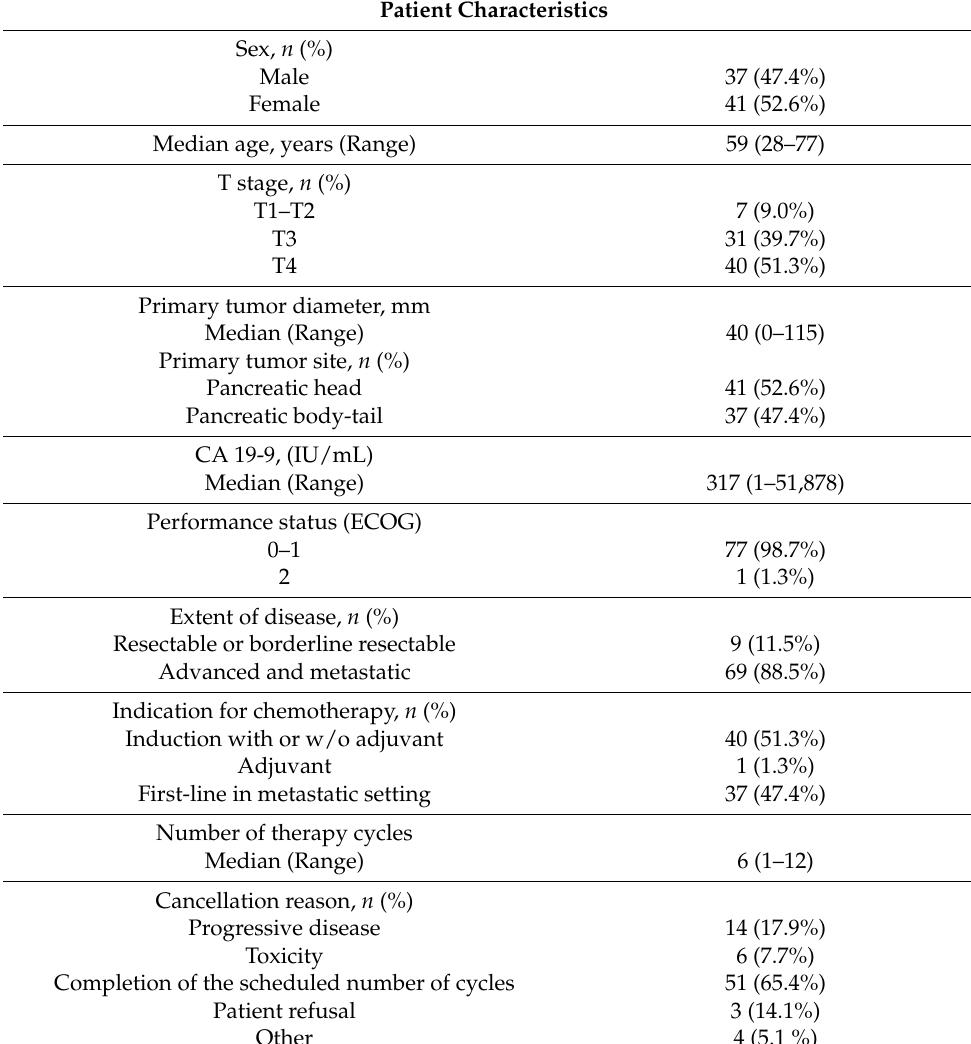
Table 1. Clinical information of PDAC